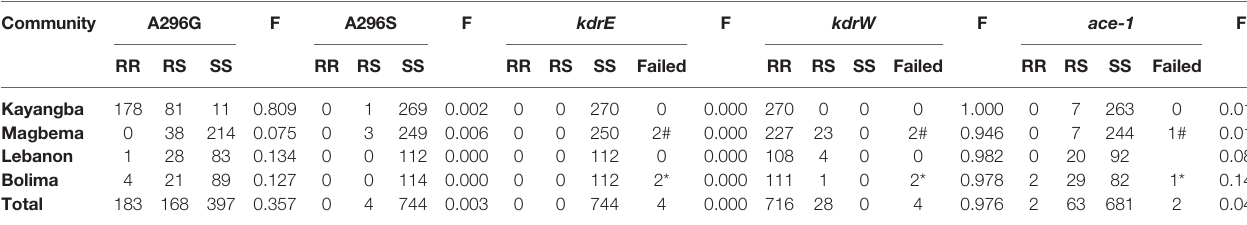
TABLE 4 | Genotypes of multiple insecticide resistance genes and their mutation frequency in the An. gambiae . Community